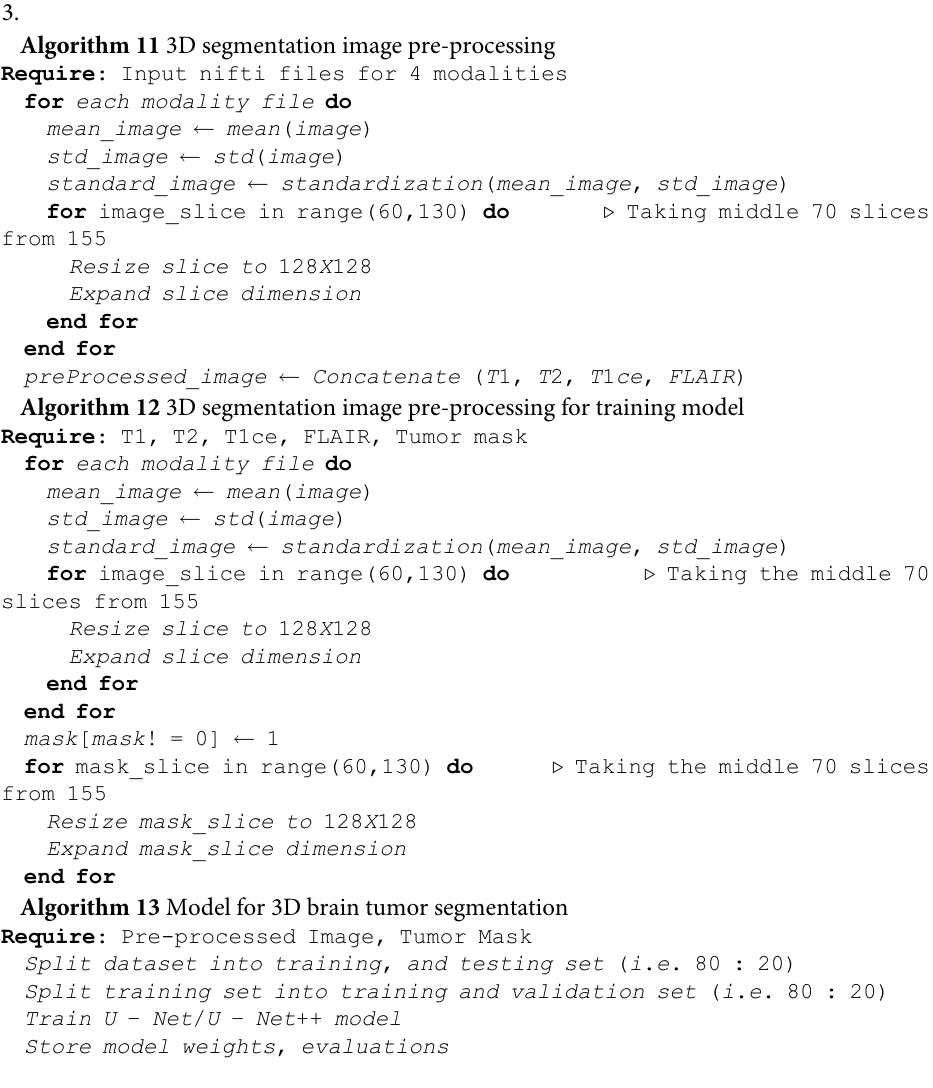
Algorithm 11 3D segmentation image pre-processing